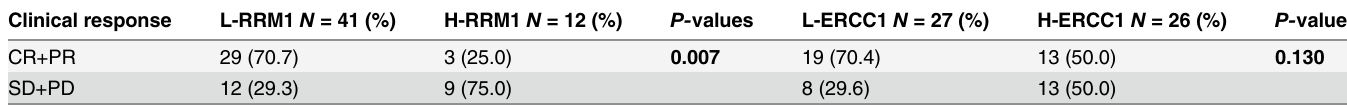
Table 2. Clinical response assessment according to RRM1 and ERCC1 expression. Clinical response